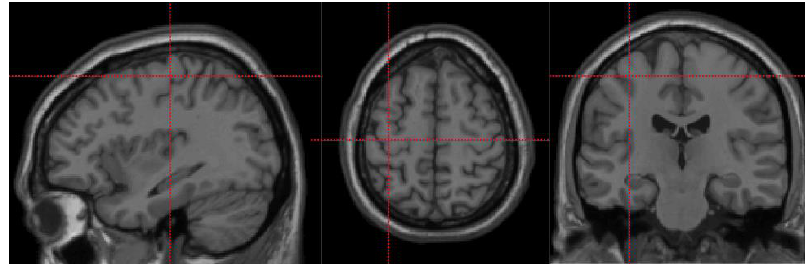
Figure 1. The core location of iTBS intervention ( − 36, − 21, 58).